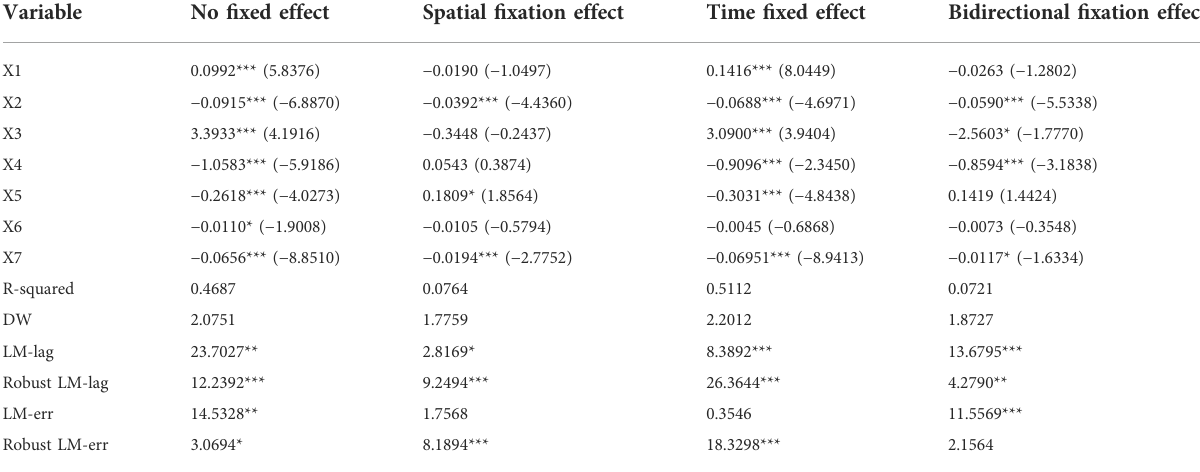
TABLE 5 Estimation and test results of common panel data